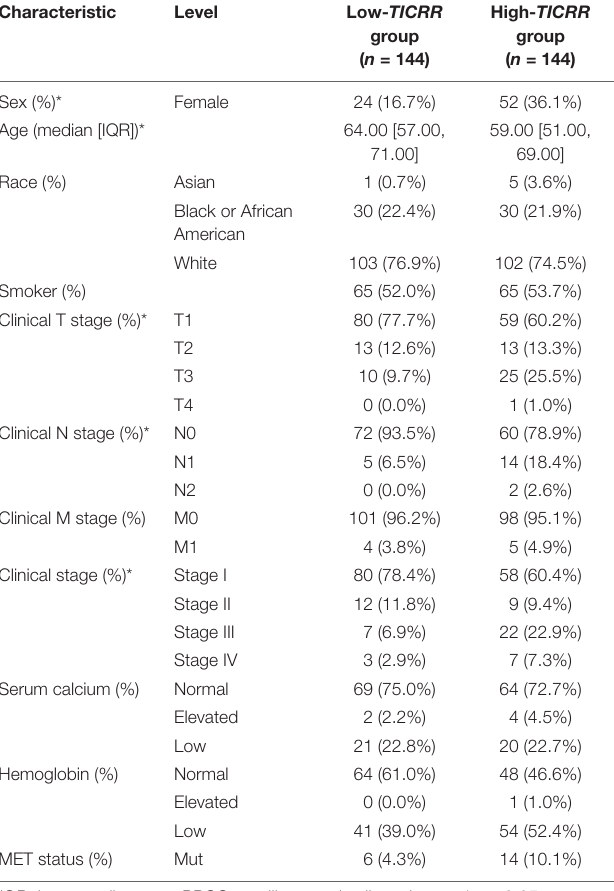
TABLE 1 | Clinicopathological characteristics of PRCC patients with differential TICRR